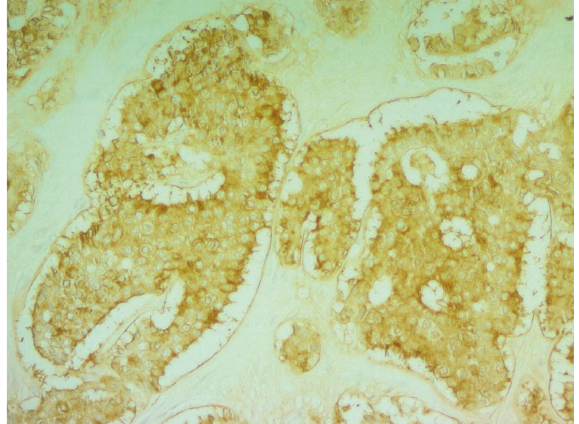
Figure 4: Chromogranin A immunohistochemical stain (cytoplas- mic staining) (200x).